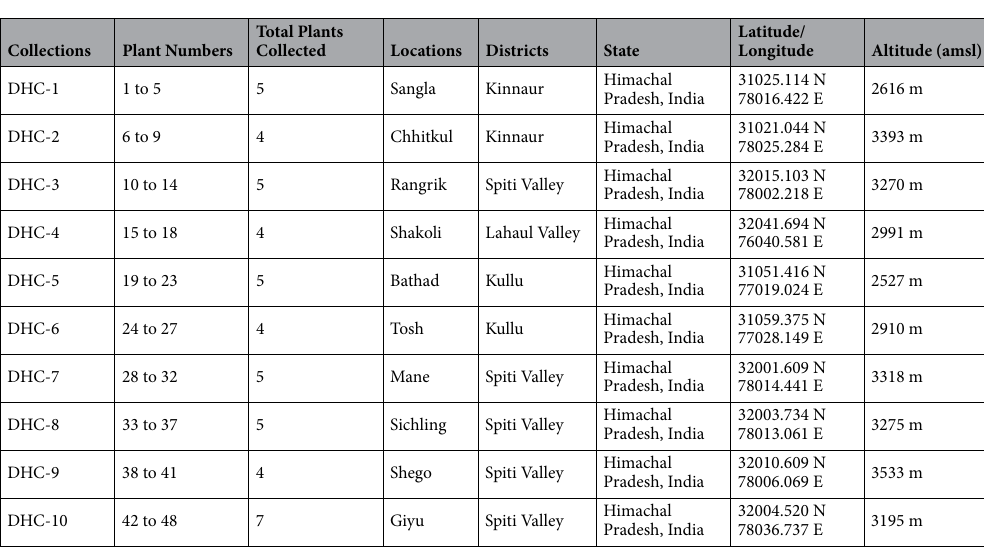
Table 6. Detail of collection of Dactylorhiza hatagirea populations from ten sites of Himachal Pradesh along with location, latitude/longitude and altitudinal